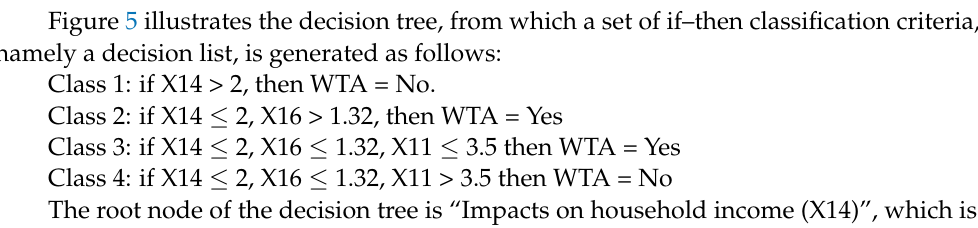
Figure 5. Classification tree of influencing factors of WTA.